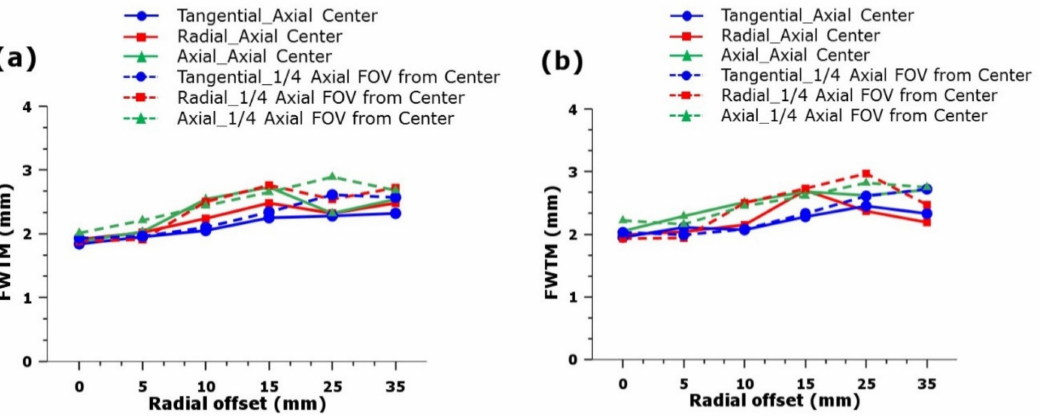
Figure 4. ( a ) FWTM of the 3D-MLEM-reconstructed images and ( b ) FWTM of the FBP- reconstructed